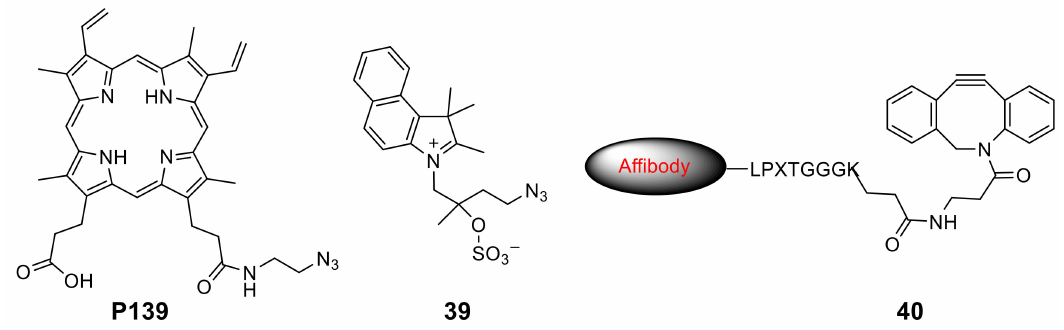
Figure 12. Structures of the azide-dyes and alkyne-a ffi body used for the preparation of a ffi body-conjugated